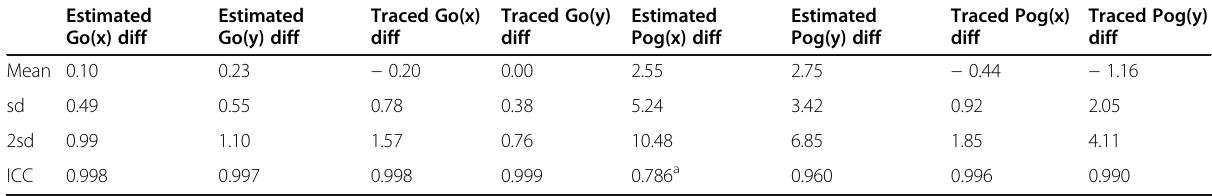
Table 1 Mean differences and average measure intraclass correlation coefficients between 12 LCR measurements taken two weeks apart Estimated Go(x)